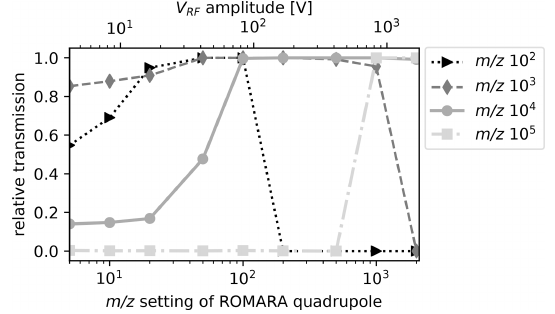
Figure 3. SIMION ® simulation of ROMARA quadrupole for heavy-ion transmission in RF-only mode for an angle of attack of 2.2 ◦ .